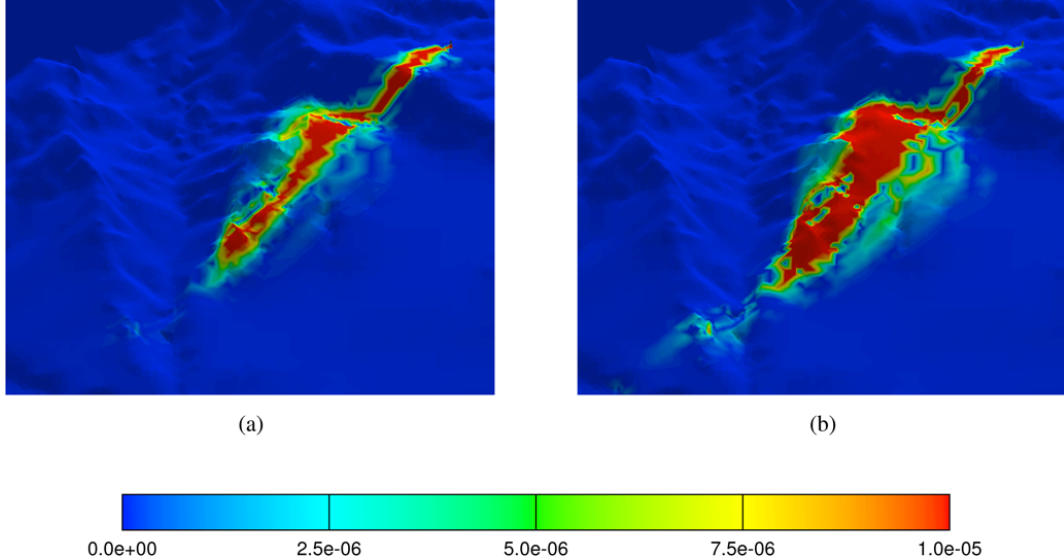
Figure 4 : Immission concentration distribution (g m − 3 ) on the terrain of the primary (a) and secondary (b) pollutants at 30 min.